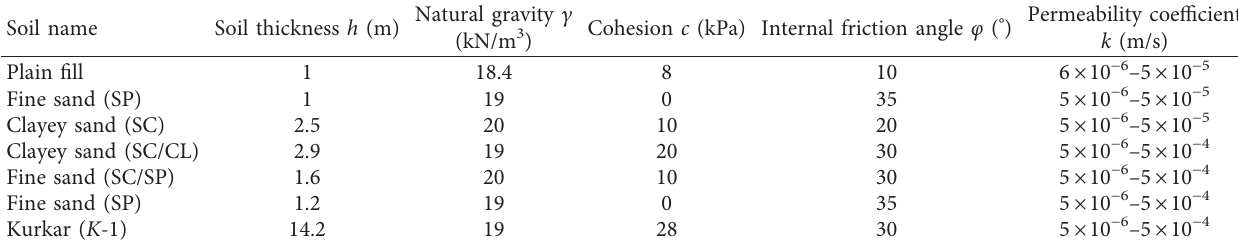
Figure 3: (a) Geological profile of the tunnel showing three exploration boreholes and (b) classification of kurkar strata in the tunnel area: (i) K -1, (ii) K -2, (iii) K -3, and (iv) K -4. Table 1: Physical and mechanical parameters of strata in the tunnel